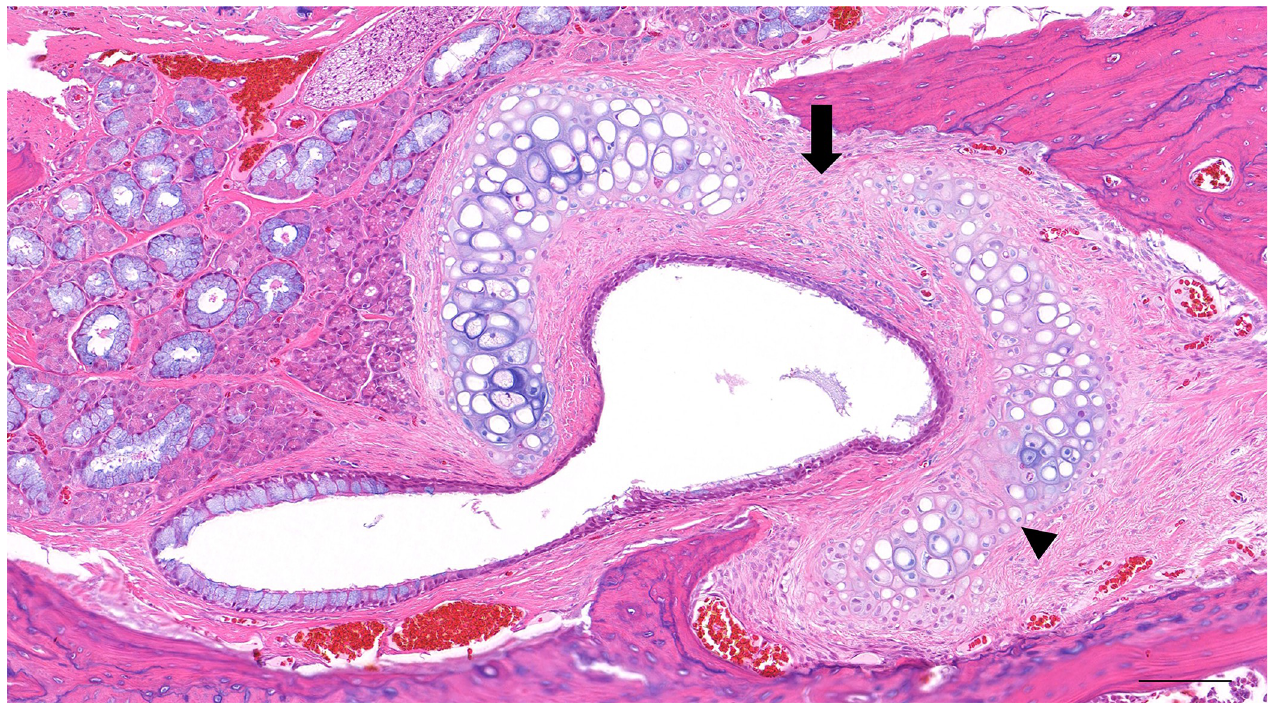
Fig 7. Sites of cartilage fracture observed in 14 of the experimental rats. The cartilage tended to fracture at three distinctive locations i.e. at the midpoint between the medial and lateral lamina of the tubal cartilage (arrow), and at the lateral two points that divide the lateral lamina into thirds (arrowhead). H&E, scale bar represents 100 μ